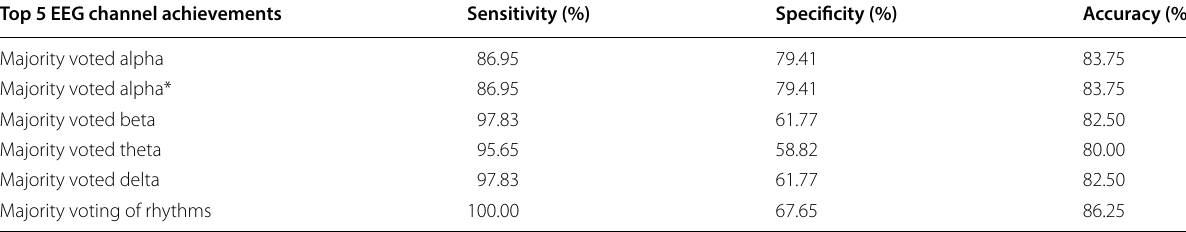
Table 6 The majority voting of the rhythm’s achievements for final emotion recognition (HV vs LV) Top 5 EEG channel achievements